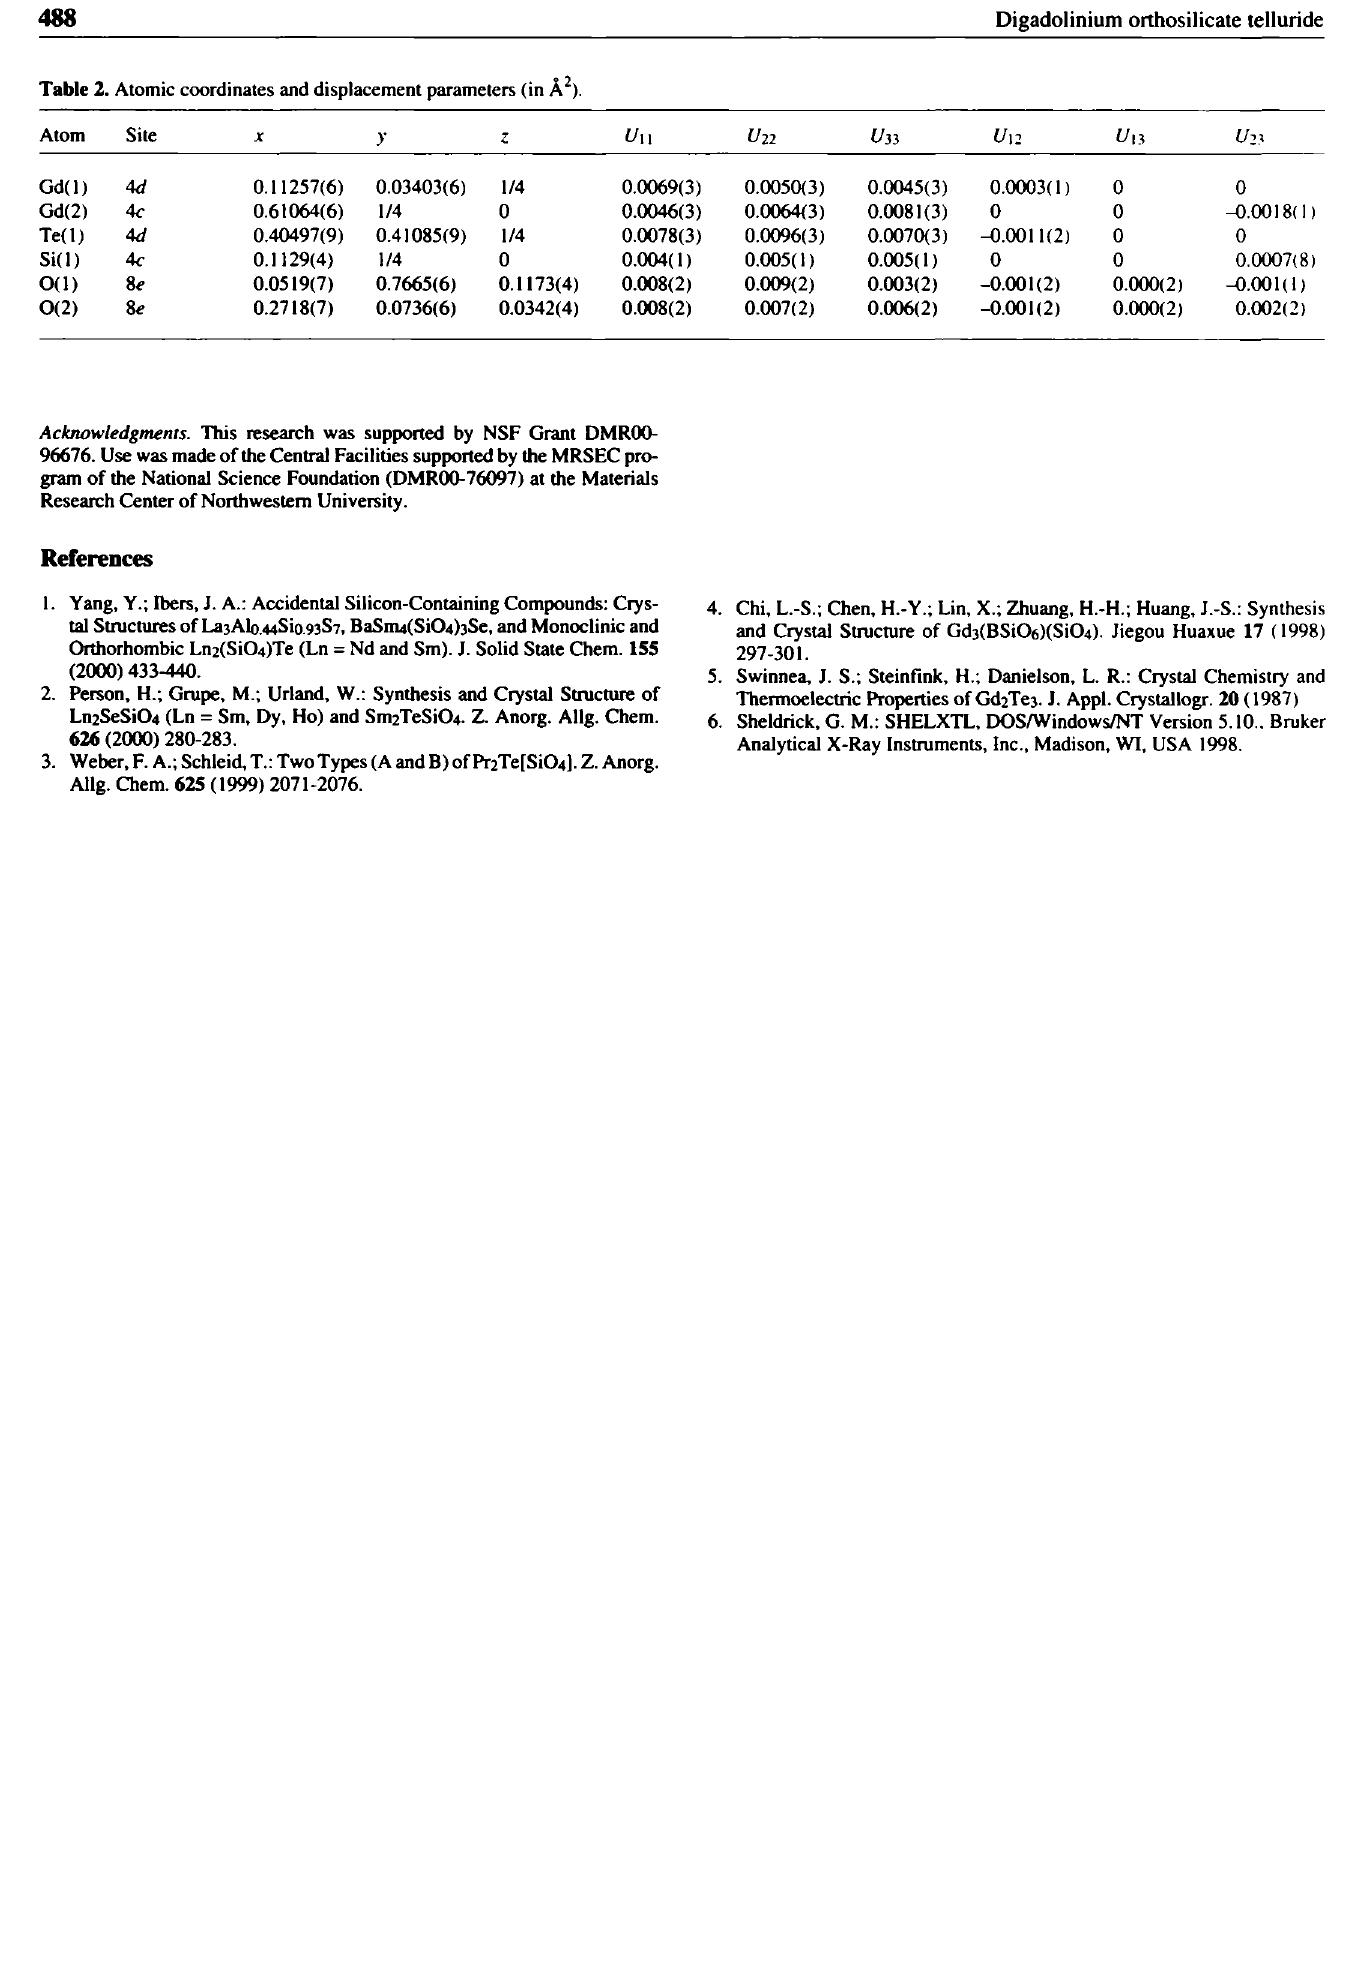
Table 2. Atomic coordinates and displacement parameters (in A 2